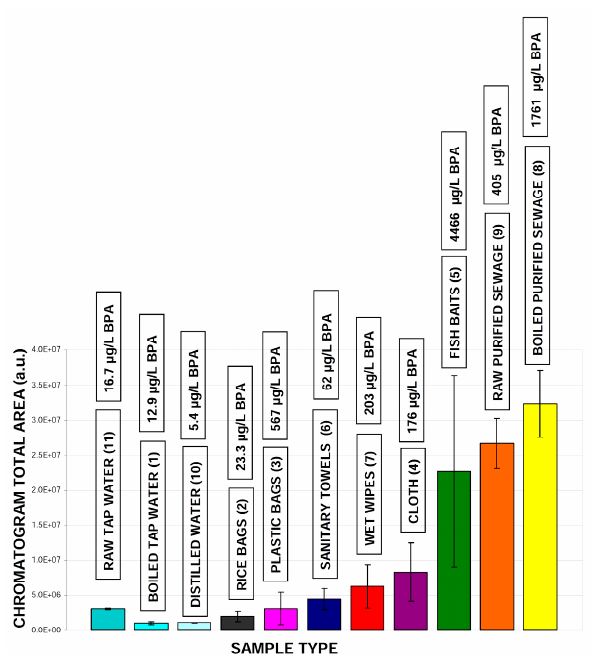
Figure 4. Integrated areas of all detected peaks on chromatograms (detection at 280 nm) calculated for various samples, which were prepared accordingly to our analytical protocol. Boxes above each material type indicate the calculated value of bisphenol A detected within each sample. Samples